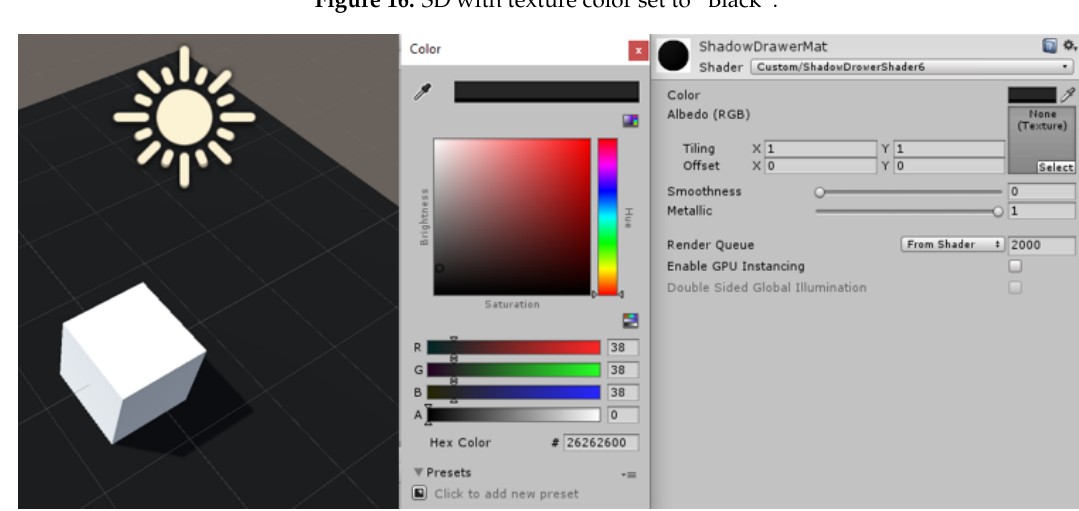
Figure 17. SD with texture color set to